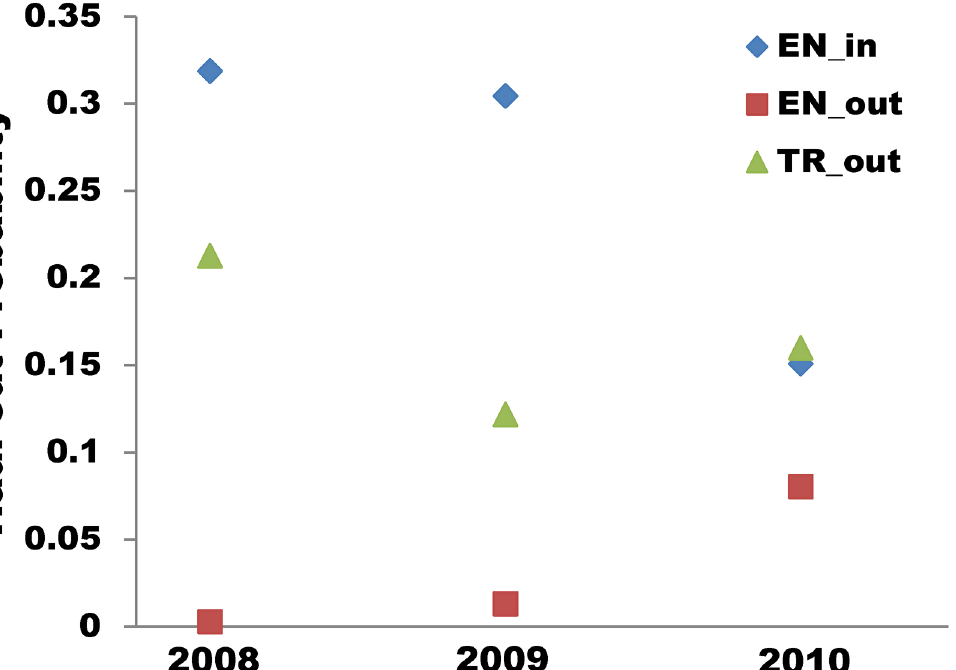
Fig 7. The probability that radio-tagged harbor seals were hauled out by inlet and year. Haul-out probability of radio-tagged seals when seals were present in inner Endicott (EN_in), outer Endicott (EN_out), and outer Tracy (TR_out) Arms in 2008, 2009, and 2010.